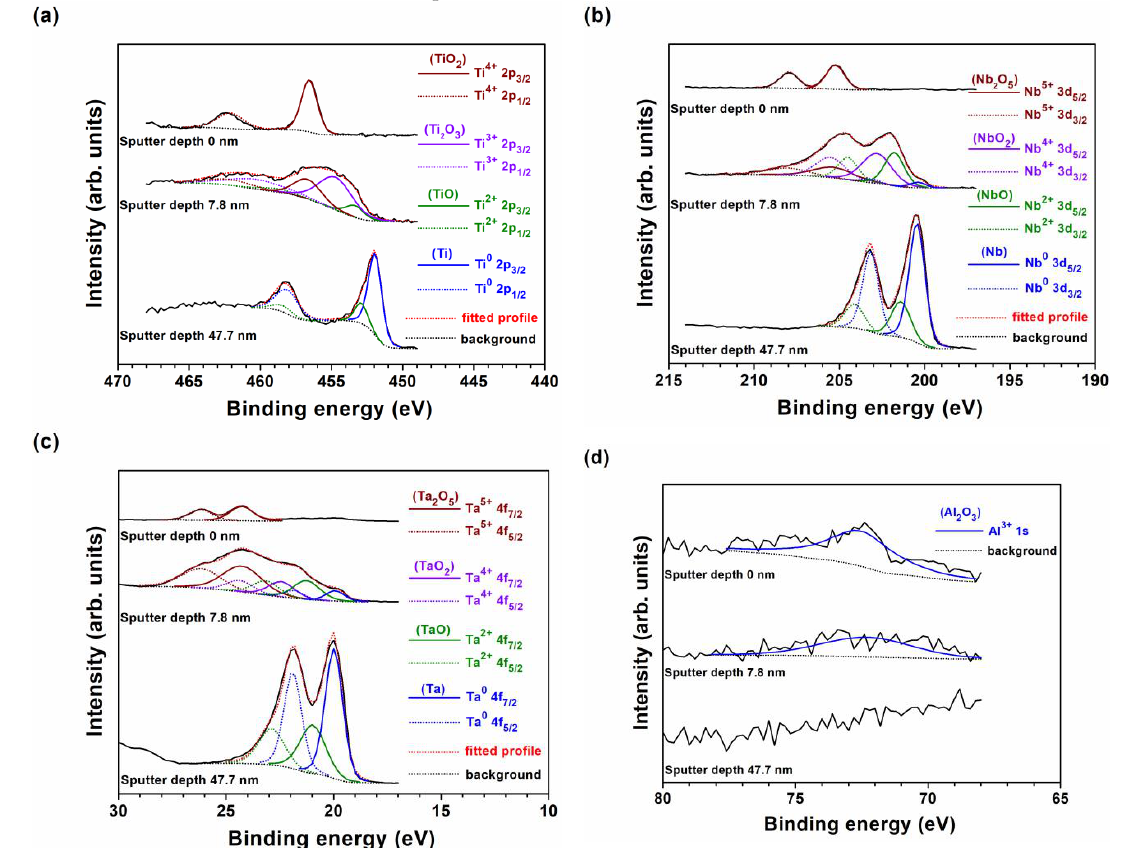
Figure 8. XPS analysis results of ( a ) Ti, ( b ) Nb, ( c ) Ta, and ( d ) Al profiles at depths of 0, 7.8, and 47.7 nm of the Ti 38 Nb 30 Ta 32 film after immersion in Ringer’s solution for eight weeks .